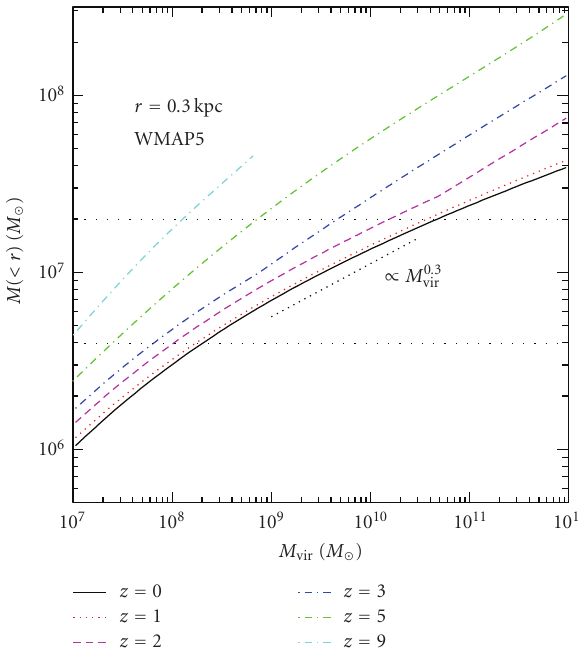
Figure 9: The mass within central 300 pc versus the total virial mass of an NFW halo predicted using the concentration mass relation c ( M vir ) at di ff erent redshifts in the concordance WMAP 5-year best fit cosmology. The horizontal dotted lines indicate the range of m 0 . 3 masses measured for the Milky Way dwarf